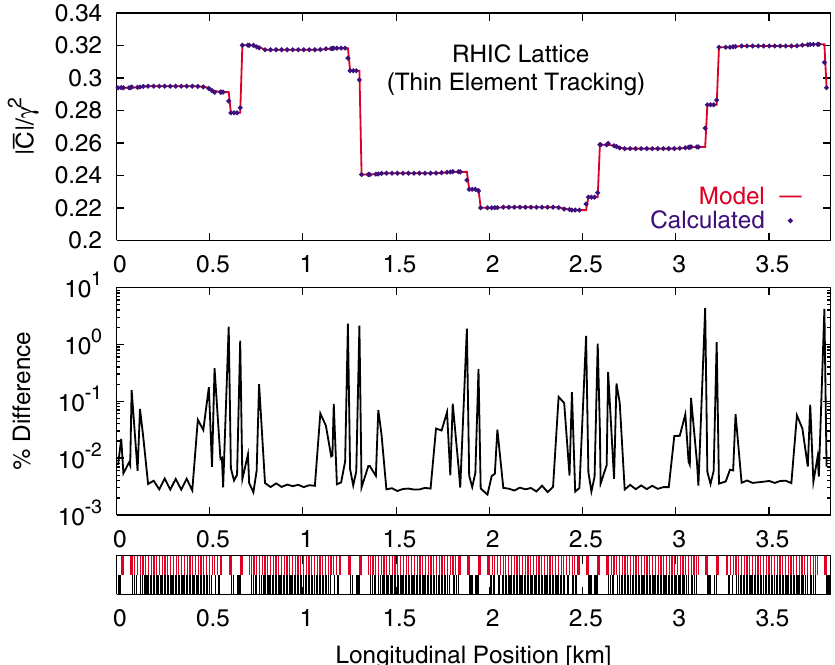
FIG. 6. (Color) Top: Comparison of j C j =(cid:20) 2 between MAD-X model and SVD computed values from tracking data. Middle: Difference between model and calculated values of j C j =(cid:20) 2 . Bottom: A representation of the lattice (dipoles in black and quadrupoles in red) is shown in the bottom graph. The horizontal and vertical tunes were Q 4 : 37 (cid:1) 10 (cid:2) 2 .